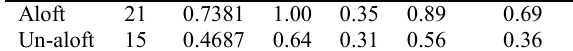
Table 2. Statistics of the ratio of the identified profiles to the